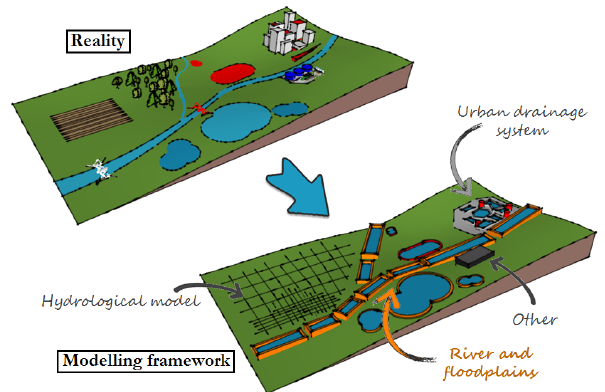
Figure 1. Schematization of the proposed modelling